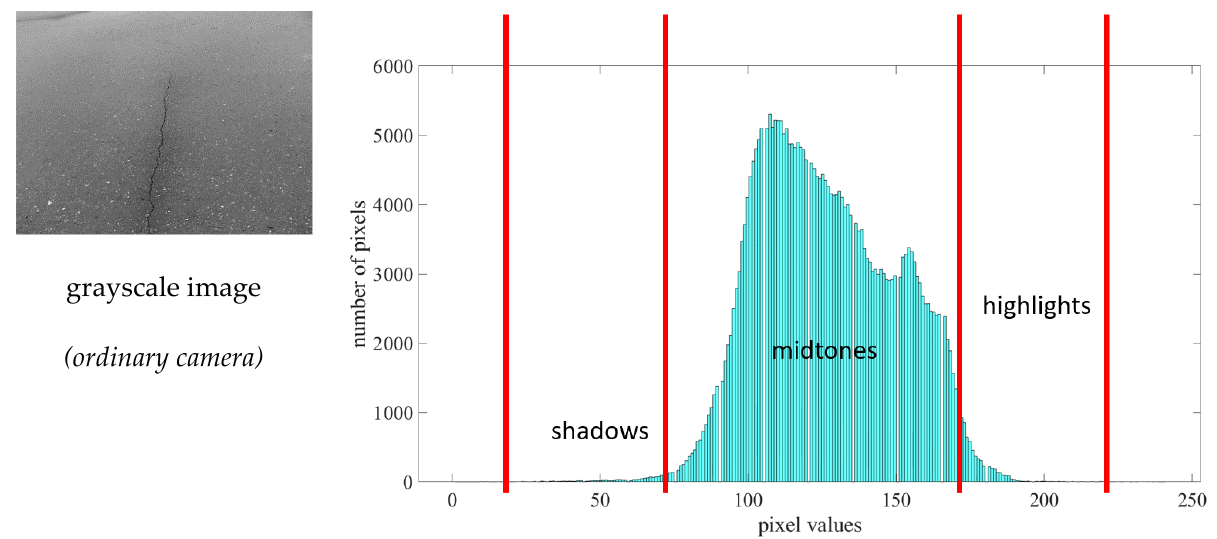
Figure 15. Histogram tonal zone representation of the sample image using an ordinary camera. Figure 16 depicts a symmetrical histogram if shifted further to the far left portion of the image. If shifted to the far left portion, the sample image might have a better contrast quality. In addition, it shows that most pixels fall between the midtone and highlight por- tions of the image.